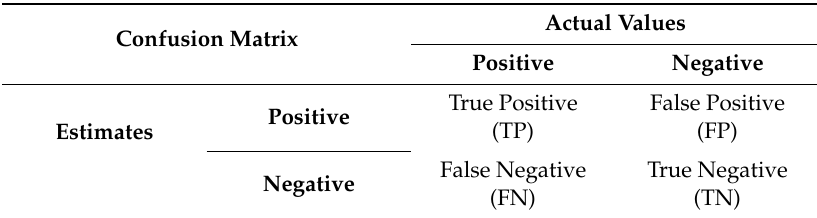
Table 4. Confusion of estimates and actual values.